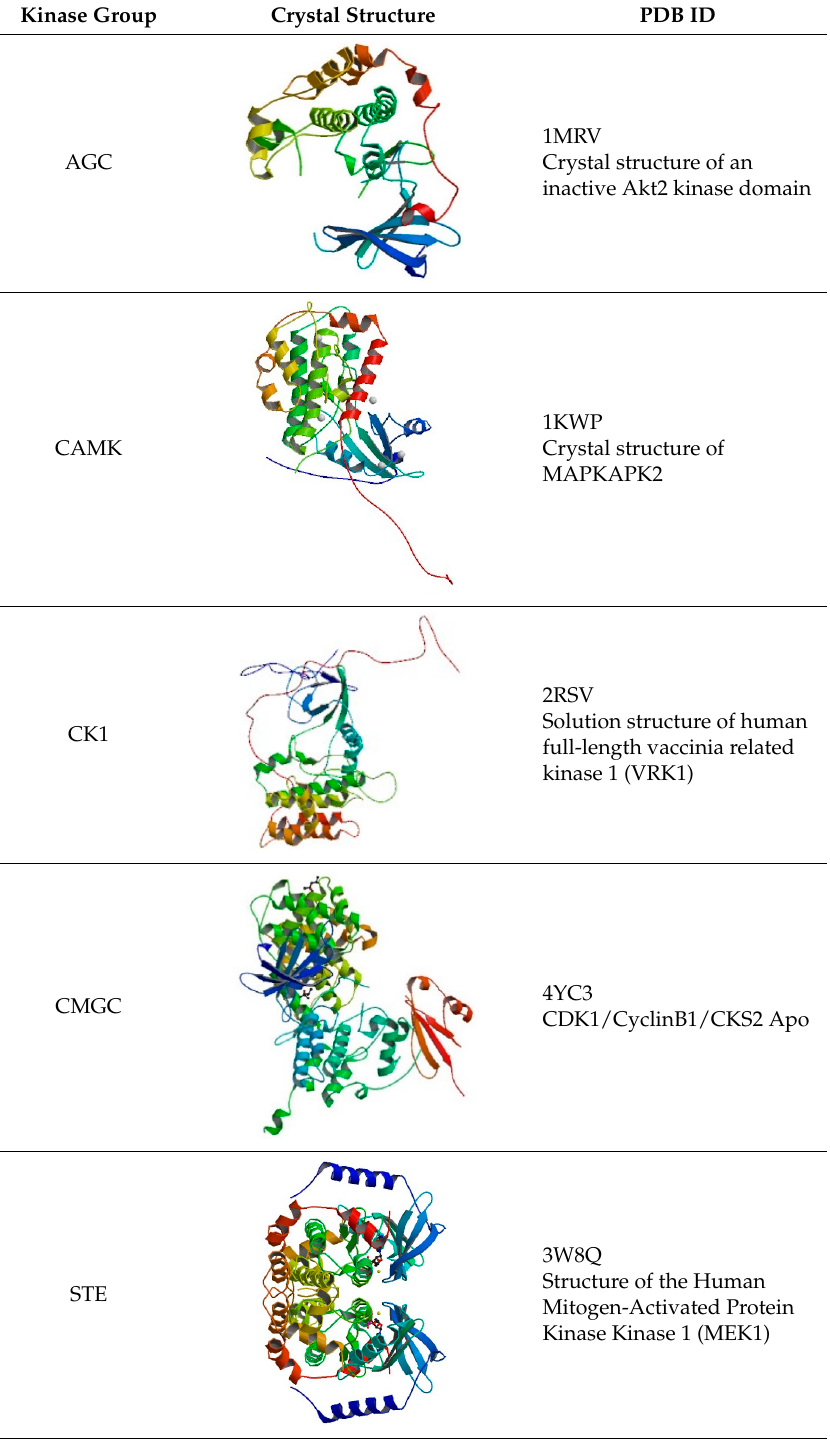
Table 1. Proposed structures for the main protein kinase family